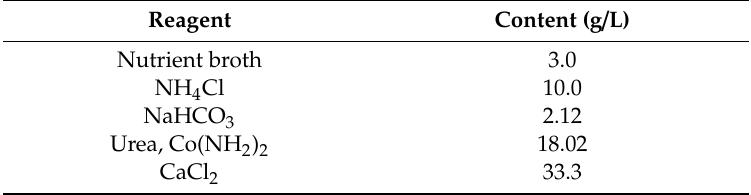
Figure 1. Particle size distribution of local beach sand from Yogyakarta south coast, Indonesia. Table 2. Standard composition of cementation solution 0.5 M (solvent in artificial